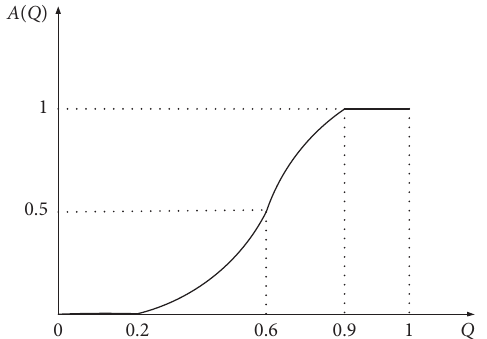
Figure 4: The membership function of fuzzy set 􏽥 A